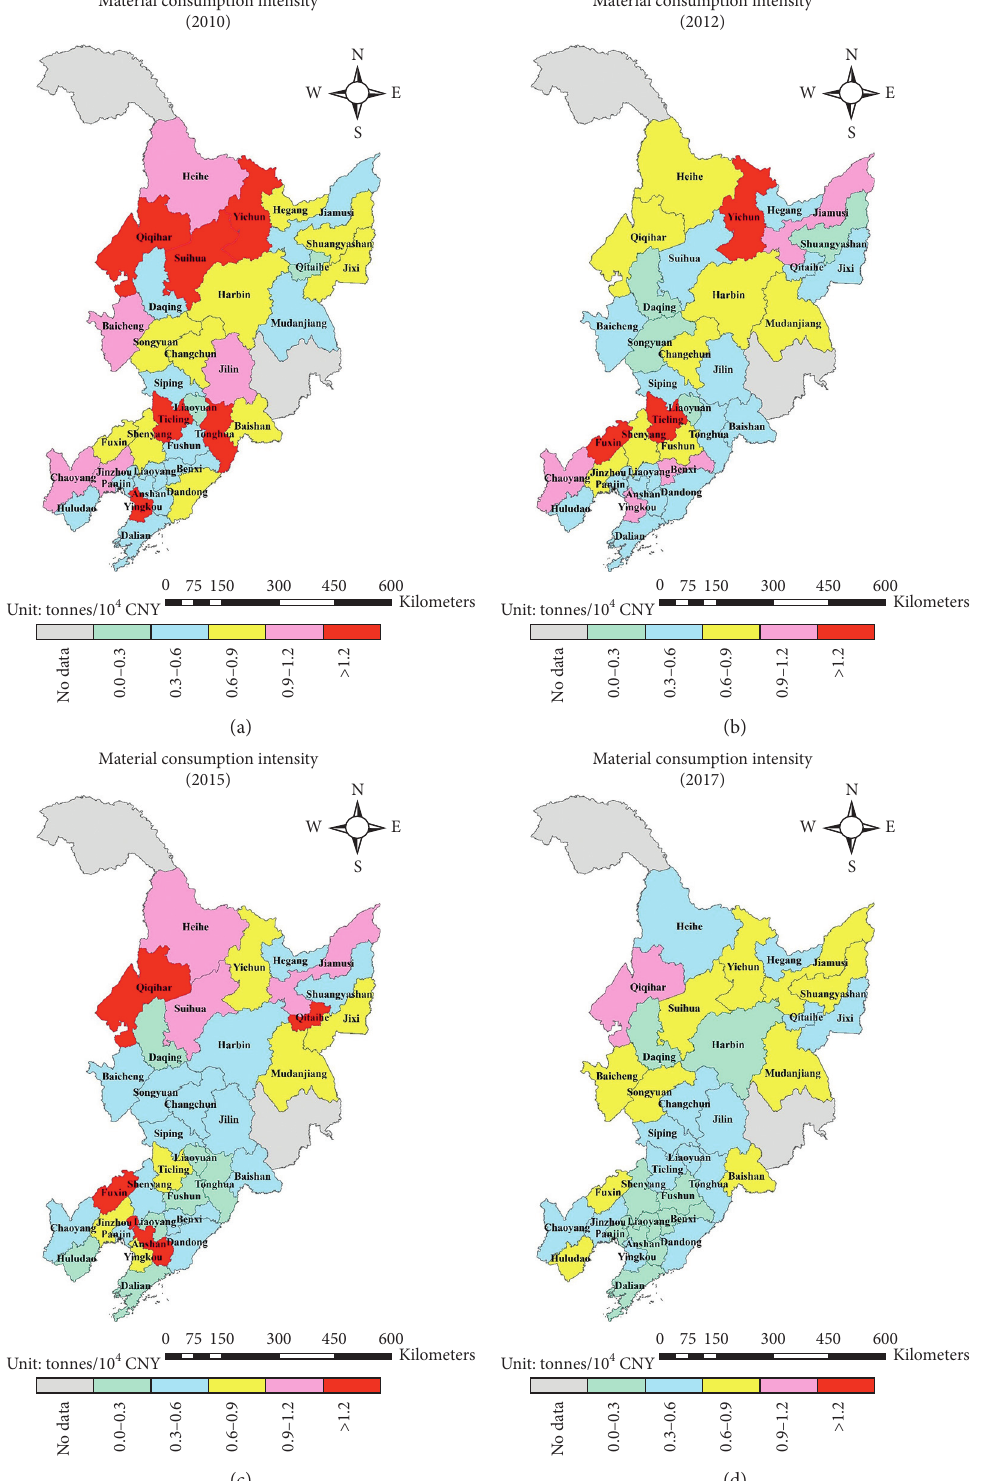
Figure 7: Spatial patterns of the material consumption intensity of infrastructure construction of 34 cities in Northeast China in 2010, 2012, 2015, and